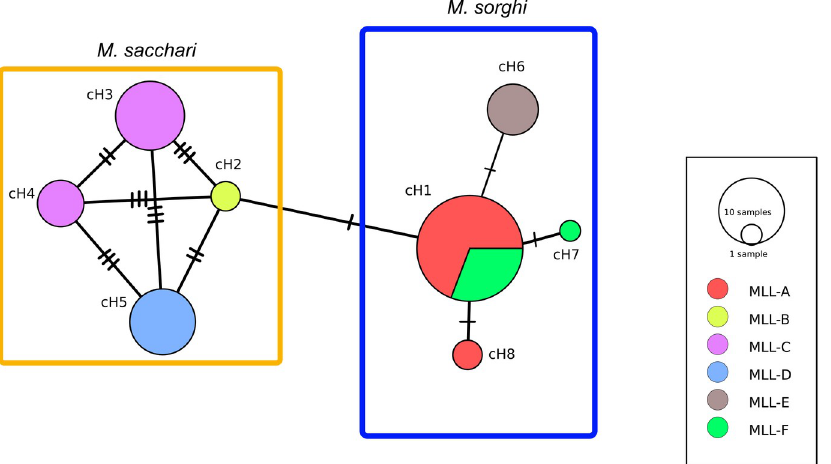
Fig 5. Minimum spanning network constructed using the concatenated COI, COII and EF1- α sequences. The orange and blue boxes indicate the STRUCTURE clusters inferred from SSR data (Table 5). The eight concatenated haplotypes (cH1 to cH8) are listed in Table 5. The number of hatch marks represents the number of mutations separating the concatenated haplotypes. Circle sizes are proportional to haplotype frequencies.